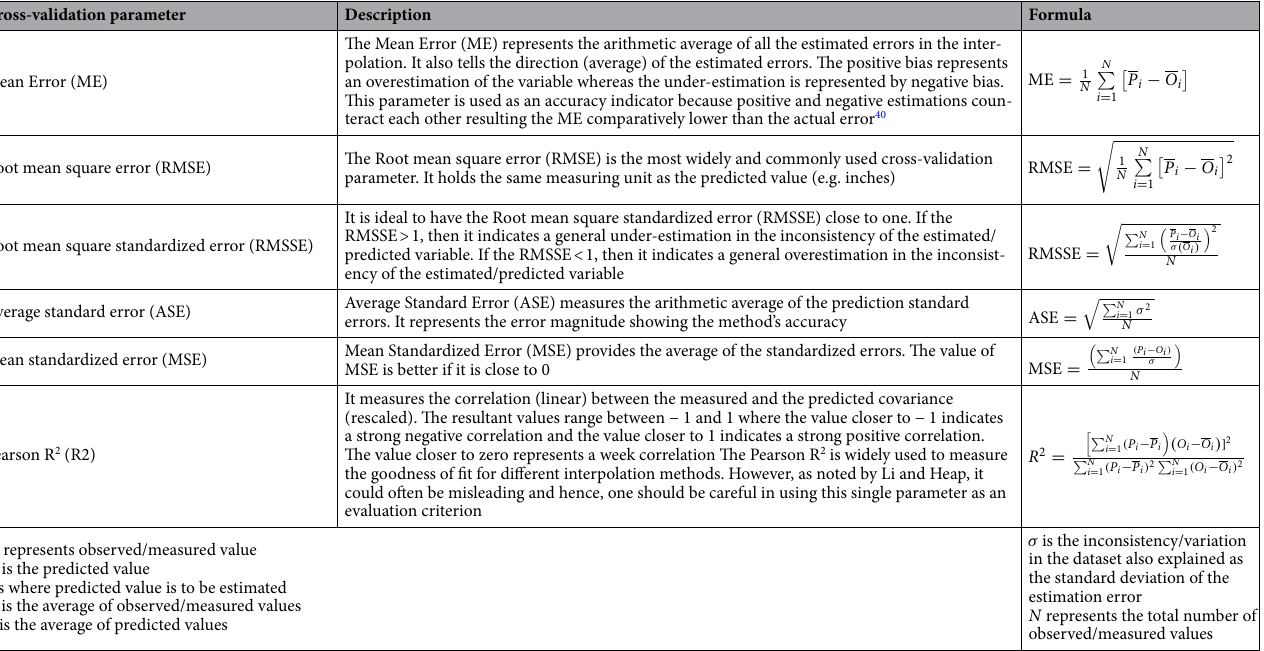
Table 1. Details on multiple cross-validation parameters used to compute the appropriateness index (AI).